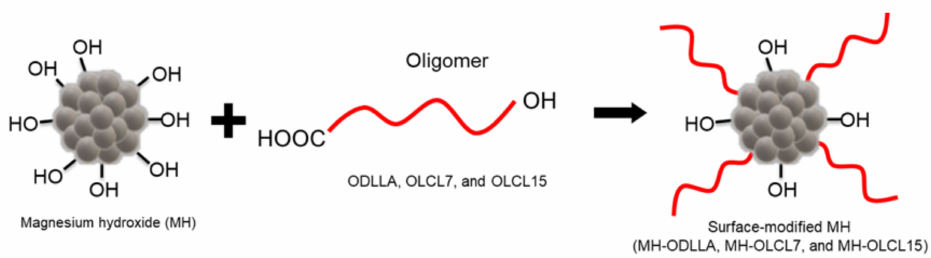
Figure 1. A schematic illustration for preparation of oligomer grafted MH